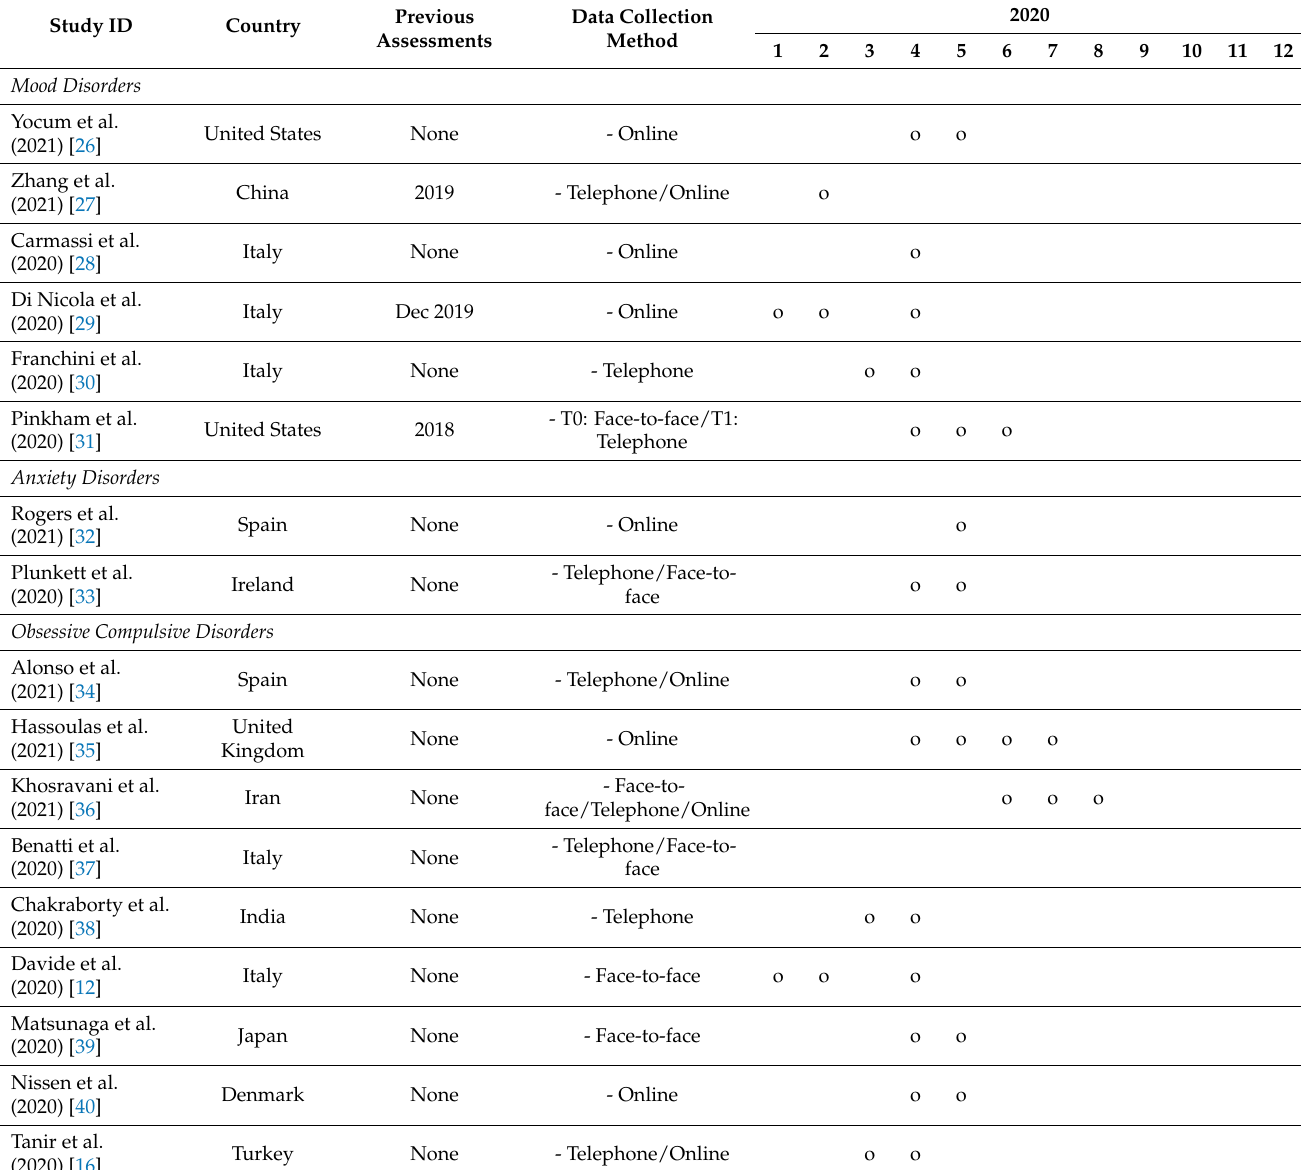
Table 2. Data collection procedure and assessment